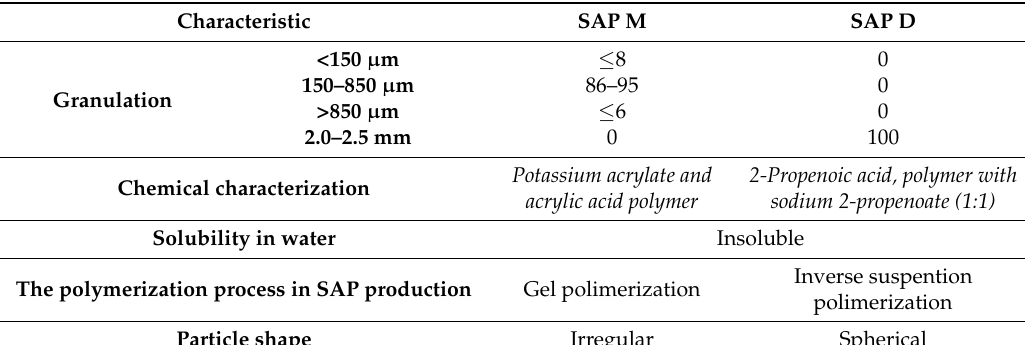
Table 1. Material characterization of the superabsorbent polymers (SAP) used in research program according to the manufacturer’s